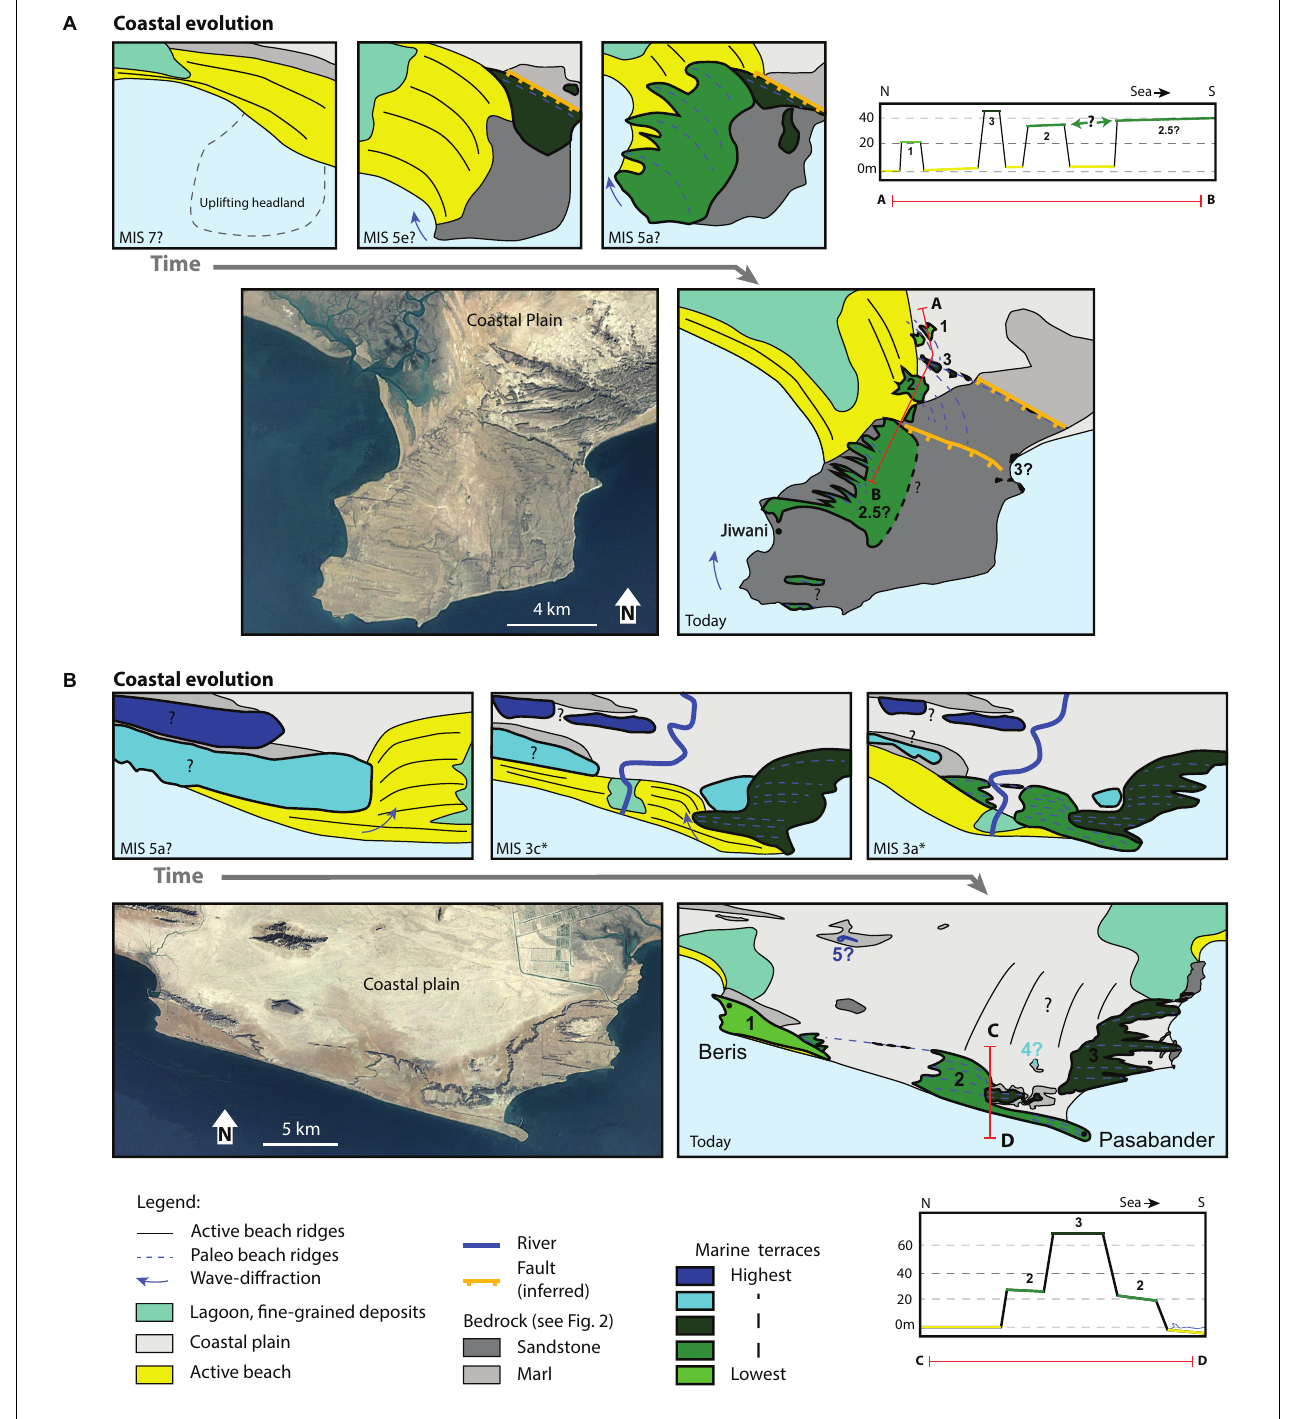
FIGURE 10 | Two examples of Makran coastal evolution models over several sea-level highstands. The presence of headlands in the form of sandstone-dominated bedrock outcrops (Jiwani) or uplifted marine terraces (Pasabander) has favored the creation of crenulated bay beaches, later uplifted into marine terraces, which in turn act as headlands. (A) Jiwani terraces coastal evolution (highstand ages are inferred, since no dating results are available in this region). Current situation is presented with a satellite image (Landsat) and interpreted terrace map. The topographic profile (A-B) through the terraces shows a landward terrace sequence and not the expected classical seaward staircase-like profile. (B) Pasabander terraces coastal evolution. ∗ Ages from OSL dating (Normand et al., 2019d). Current situation is presented with a satellite image (Landsat), interpreted terrace map [modified after Normand et al. (2019d)] and topographic profile C,D.